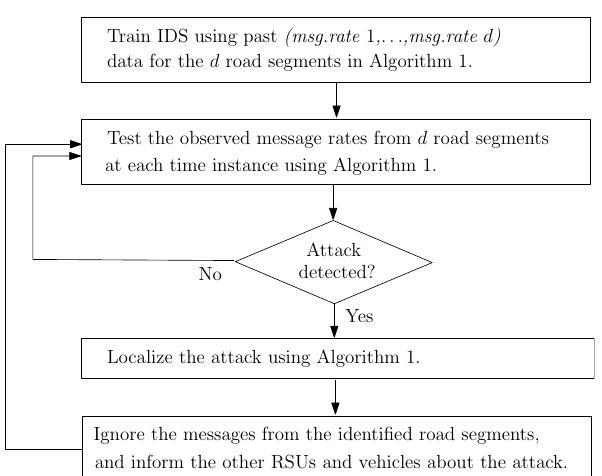
Figure 4. Flowchart of the proposed IDS for DDoS